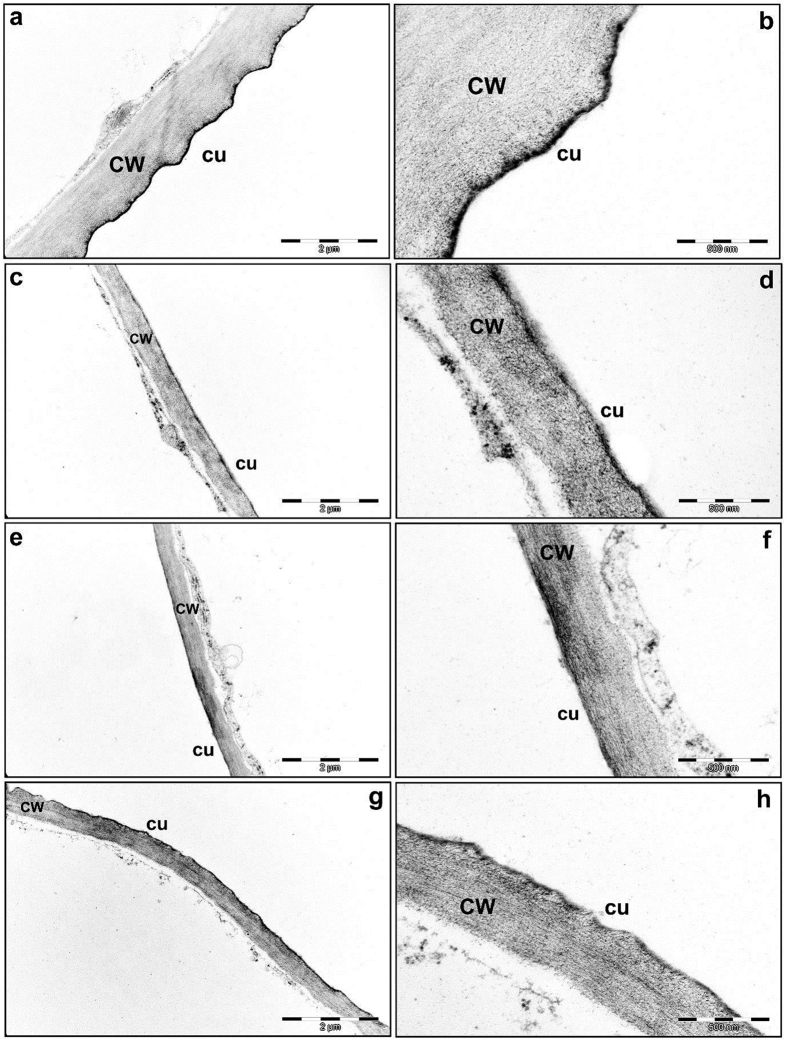
Ultrastructure differences in cuticle of rosette leaves of WT, and tgg1, tgg2 single and tgg1 tgg2 double mutants of Arabidopsis as examined through transmission electron microscopy (TEM).(a,b) WT: The cuticle is visible as a continuous, condensed and dark electron dense apposition on the cell wall. (c,d) tgg1 single mutant, (e,f) tgg2 single mutant, (g,h) tgg1 tgg2 double mutant. The cuticle in tgg1, tgg2 single and tgg1 tgg2 double mutants is visible as a disrupted and irregular electron-dense apposition on the cell wall. Bars = 2 μm (X 18,500 magnification in a,c,e and g), =500 nm (X 68,000 magnification in b,d,f and h). Cu, cuticle; and CW, cell wall.